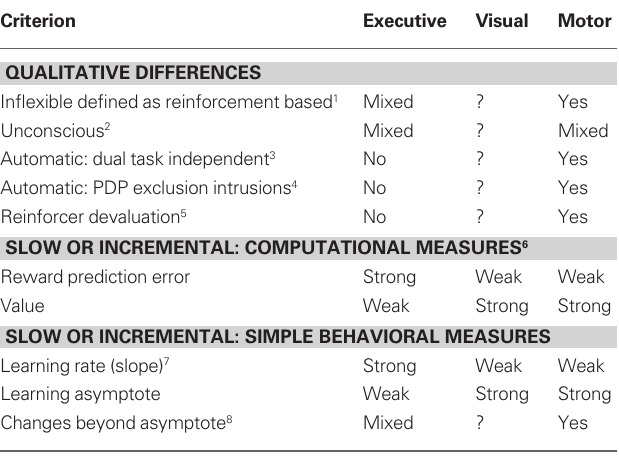
Table 1 | Habit learning criteria within dorsal corticostriatal